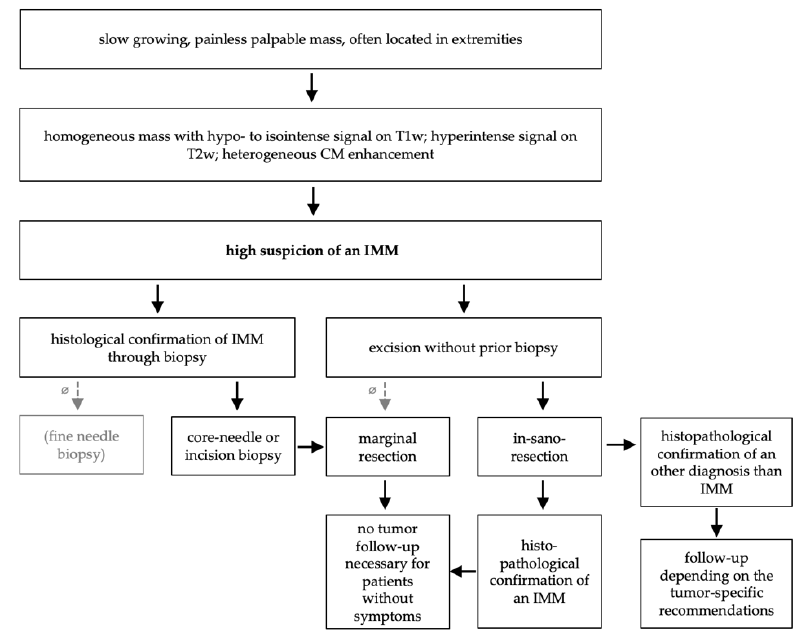
Figure 3. Recommended diagnostic and therapeutic pathway for IMM at a specialized tumor center. Based on our analysis and the current literature.